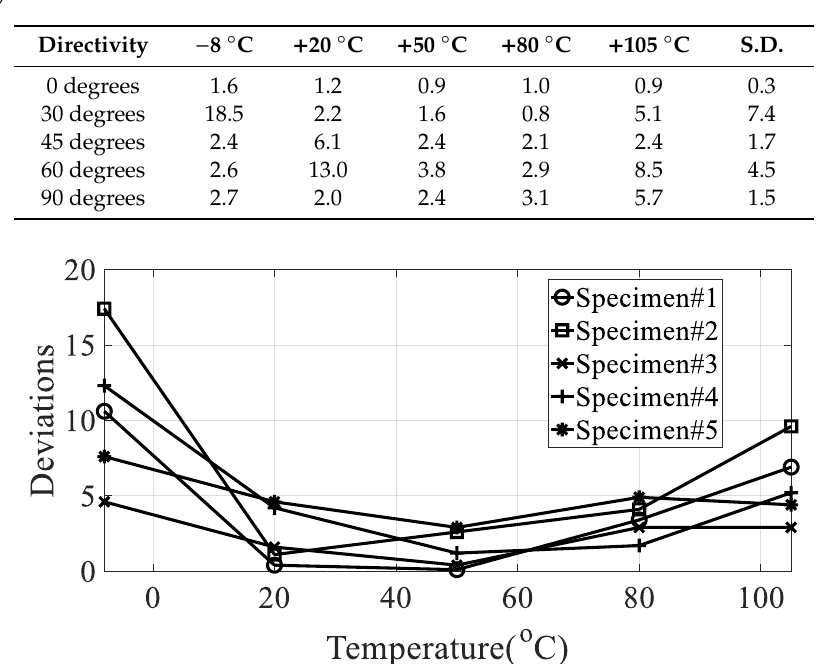
Table 4. Variation of the modal damping coefficient according to different temperature conditions (Unit: %).